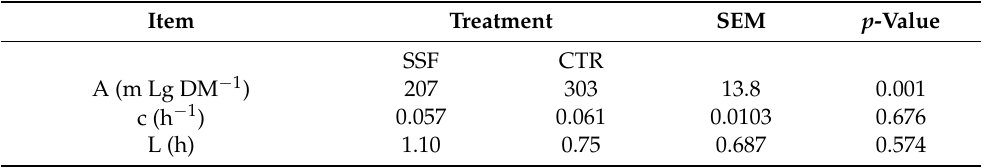
Table 2. Effects of solid state fermentation process on the in vitro gas production profile of fruit and vegetable mix